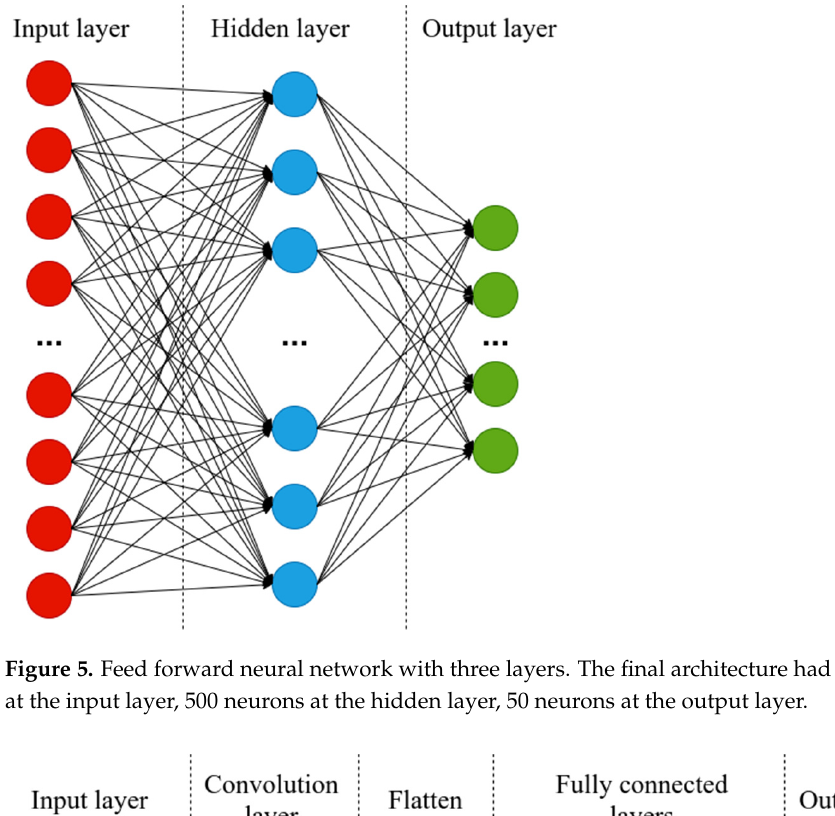
Figure 5. Feed forward neural network with three layers. The final architecture had 20,001 neurons at the input layer, 500 neurons at the hidden layer, 50 neurons at the output layer.